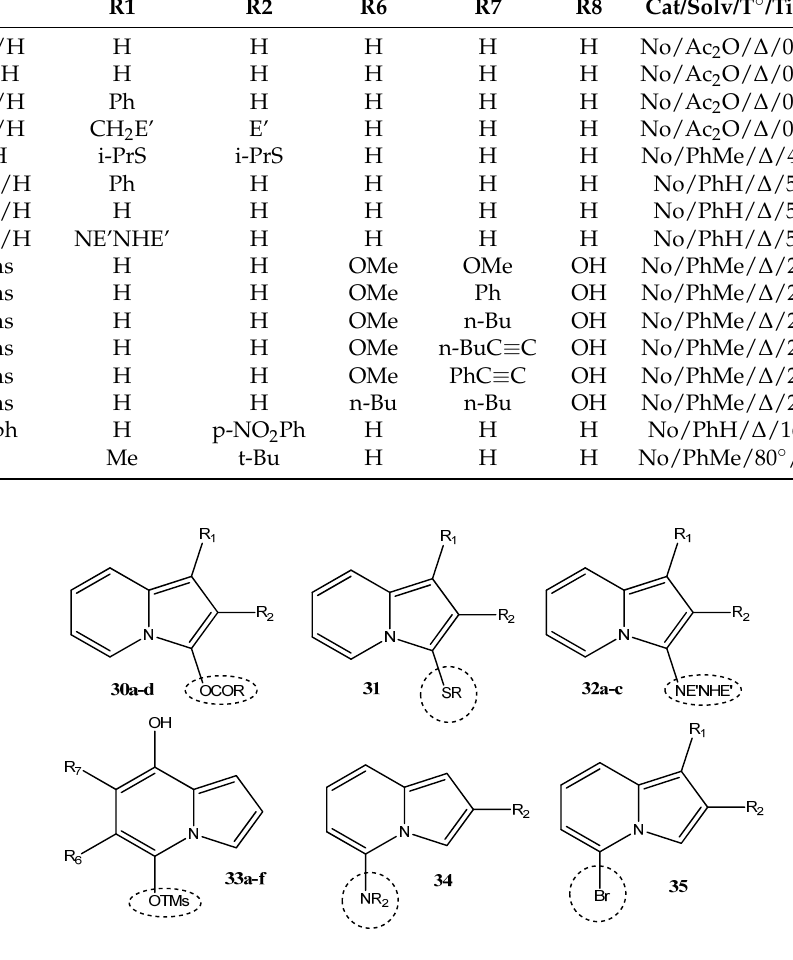
Table 7. Substituents, conditions and yields in cycloaddition of acetylenes to 3(5)-substituted indolizines giving cyclazines (Scheme